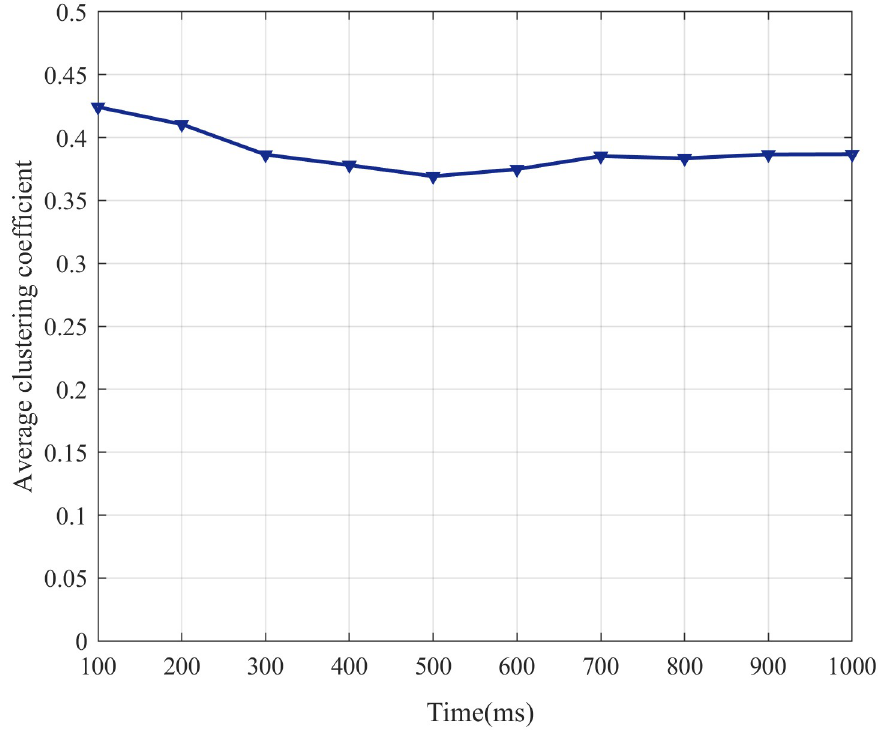
Fig 17. The change in the ACC with